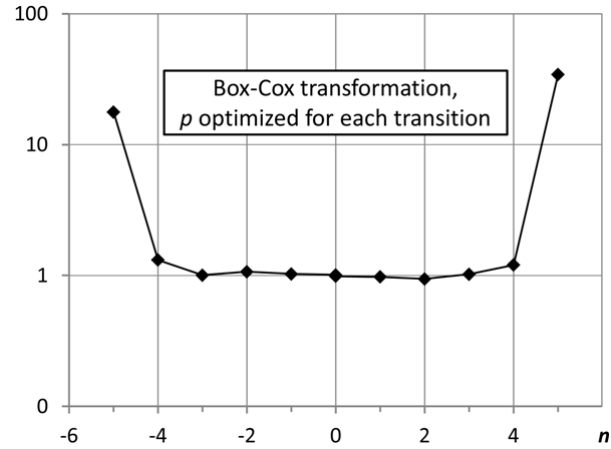
Box–Cox transformations applied to all